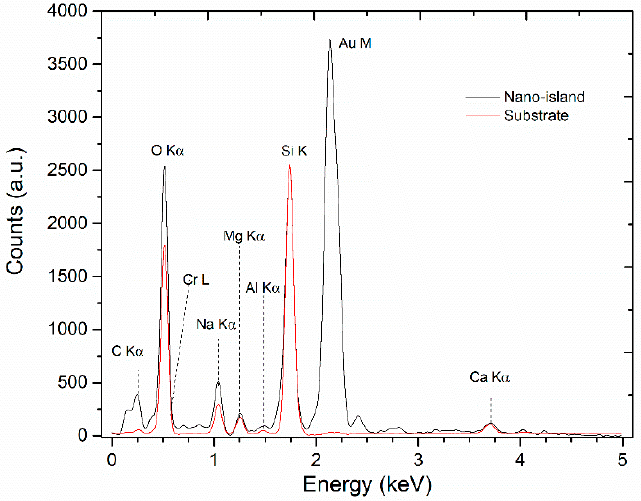
Figure 4. Energy Dispersive X-ray Spectroscopy (EDS) analysis of a 6 nm sample after annealing at 600 °C for 1 h.